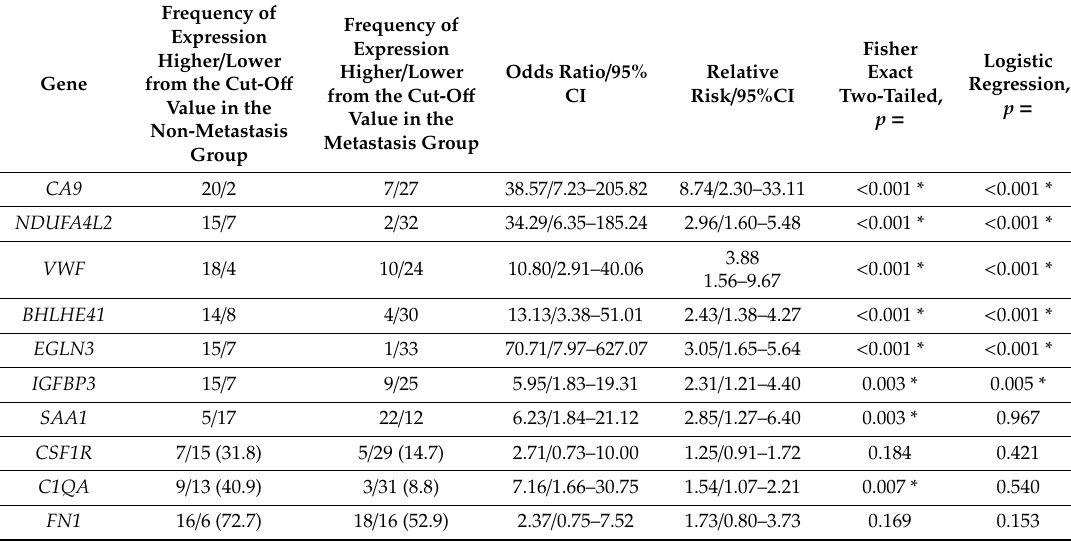
C1QA 3 / 31 (8.8) 16 / 6 (72.7)